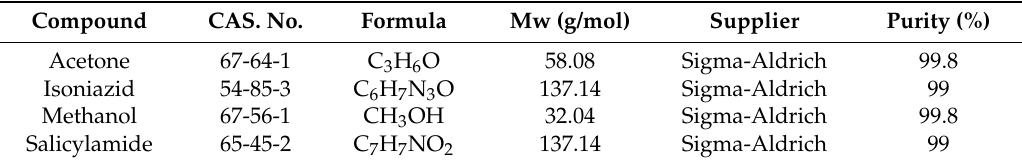
Table 1. Specifications of the chemical samples used in this study. Compound CAS.